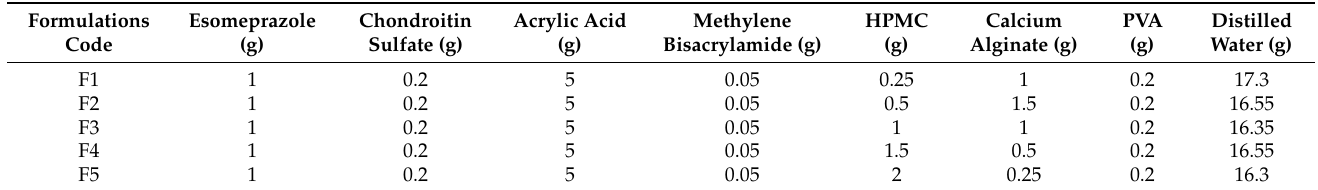
Table 1. Composition of esomeprazole-loaded hydrogel formulations